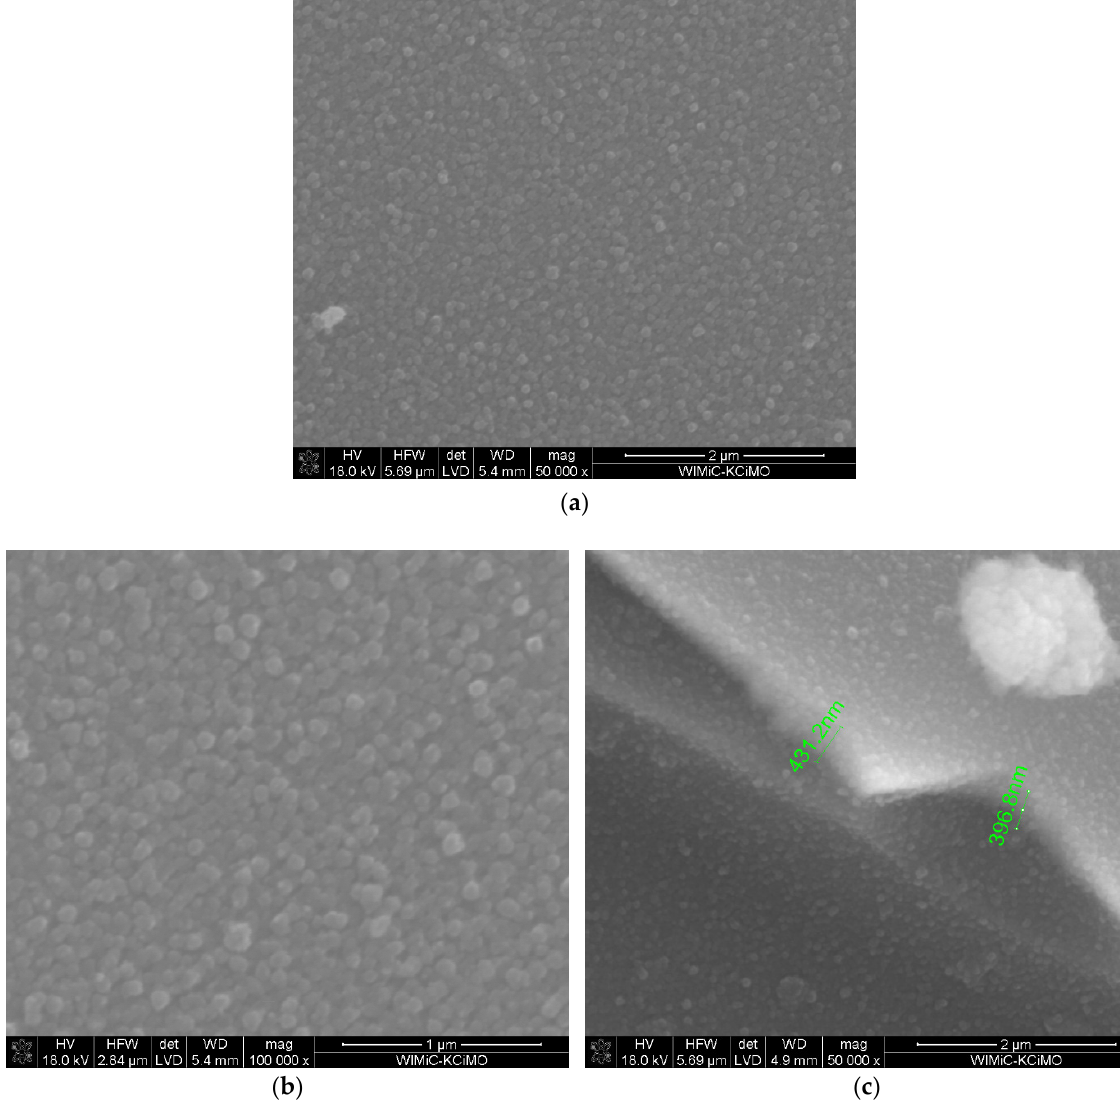
Figure 4. Microstructure of the layer obtained at temperature of 650 °C on tubular substrate at different magnifications: 50,000× ( a ) and 100,000× ( b ) and the cross-section: the layer (bright part)–the substrate (dark part) ( c ). The content of Sc(tmhd) 3 in the gas mixture: 28 mol.%. Total gas pressure: 6580 Pa. Deposition time: 40 min.